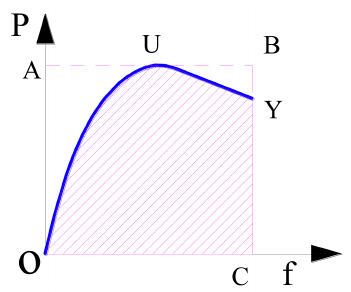
Figure 18. The sketch of energy consumption coefficient.